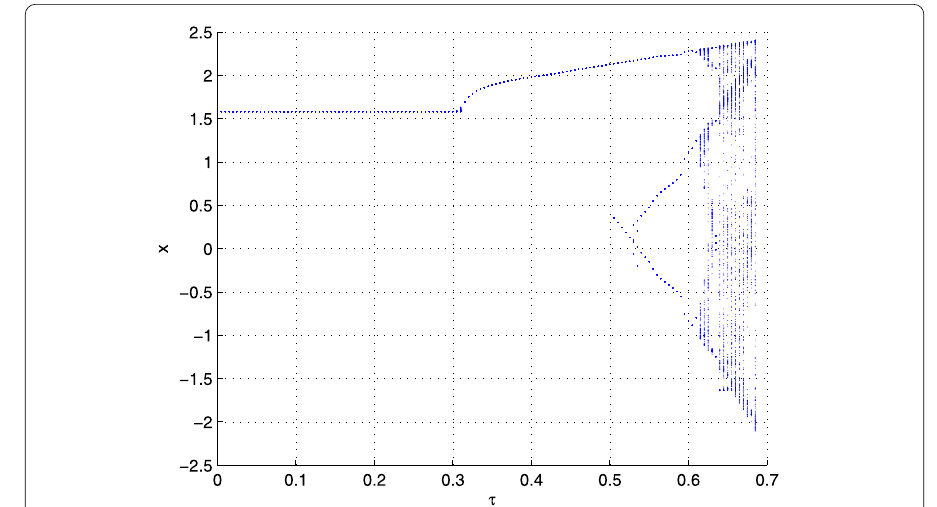
Figure 10 The bifurcation diagram of system (17) with the parameter γ = 2.5